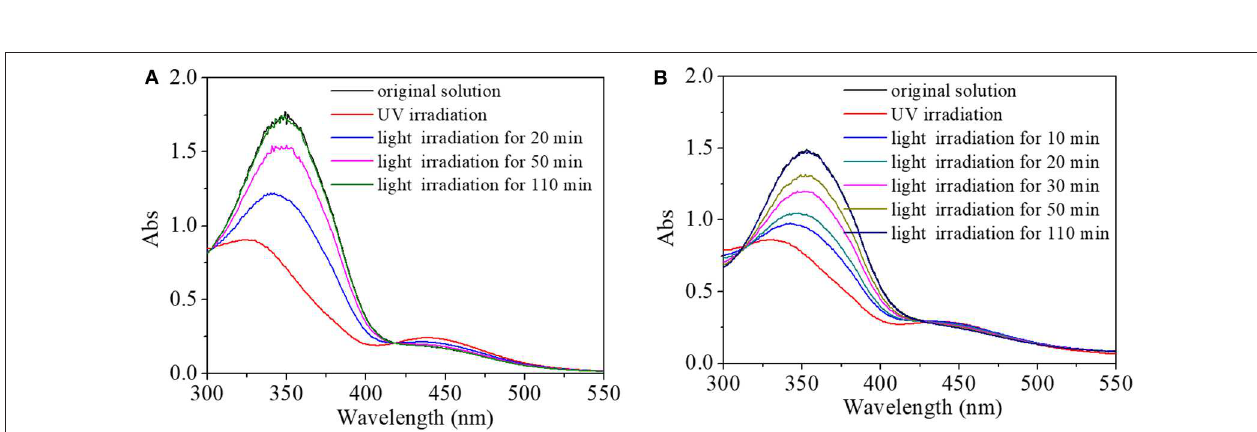
FIGURE 6 | UV spectra of (A) HEMA-NVP-AZO/poly( β -CD) and (B) HEMA-NVP-AZO/poly( α -CD) nanoparticle solution response to UV/white light as a function of recovery time under 73 µ W/cm 2 white light at 20 ◦ C.